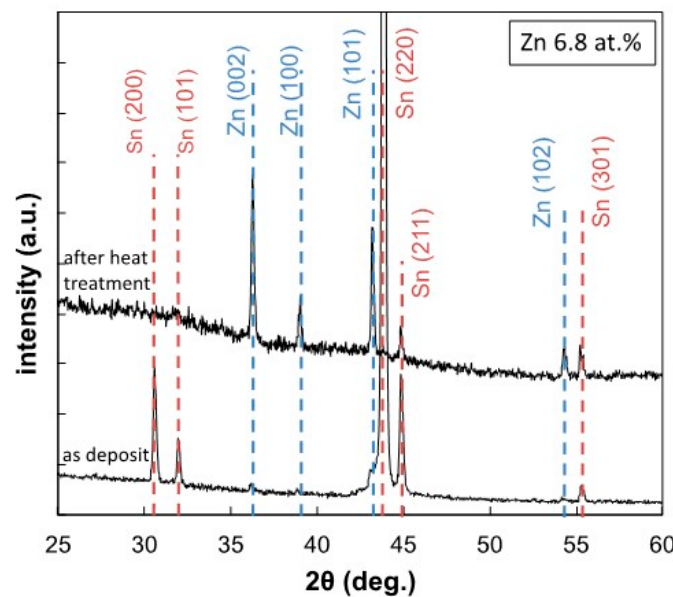
Figure 7. Effect of thermal annealing on the XRD profiles of an electrodeposited Sn-6.8 at.%Zn alloy film.